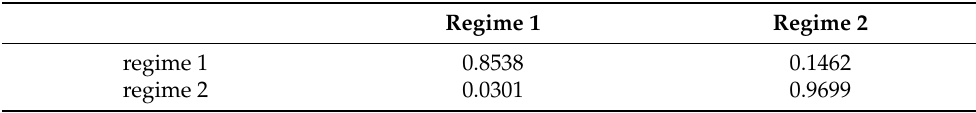
Table 2. Transition matrix of joint